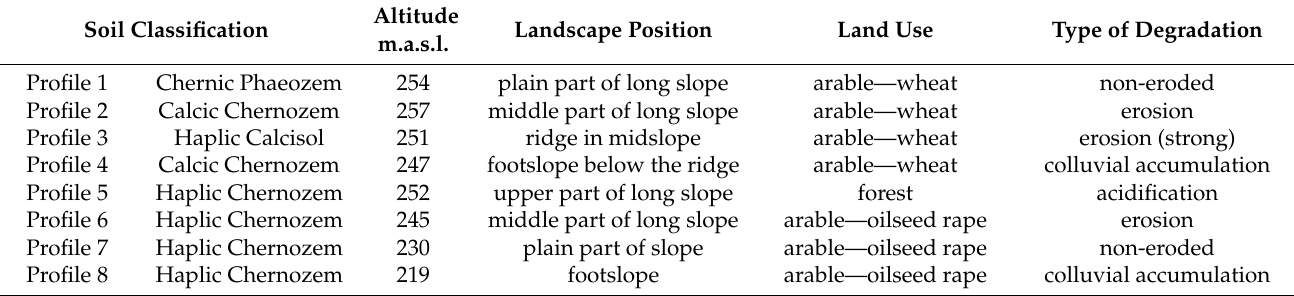
Table 1. Soil location, land use and